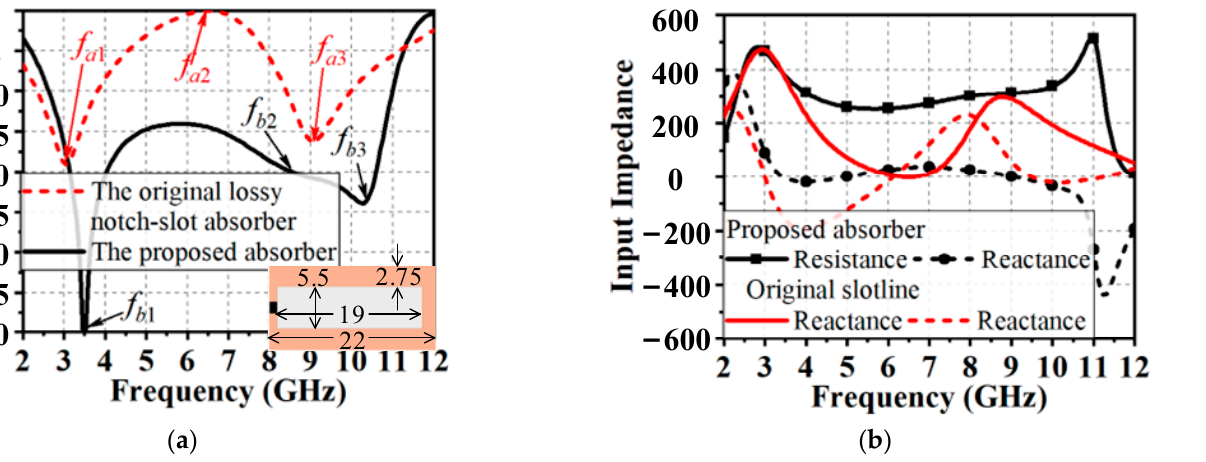
Figure 2. ( a ) Simulated | S 11 | of the proposed and the original 3D absorber; ( b ) simulated input impedance of the proposed and the original 3D absorber.